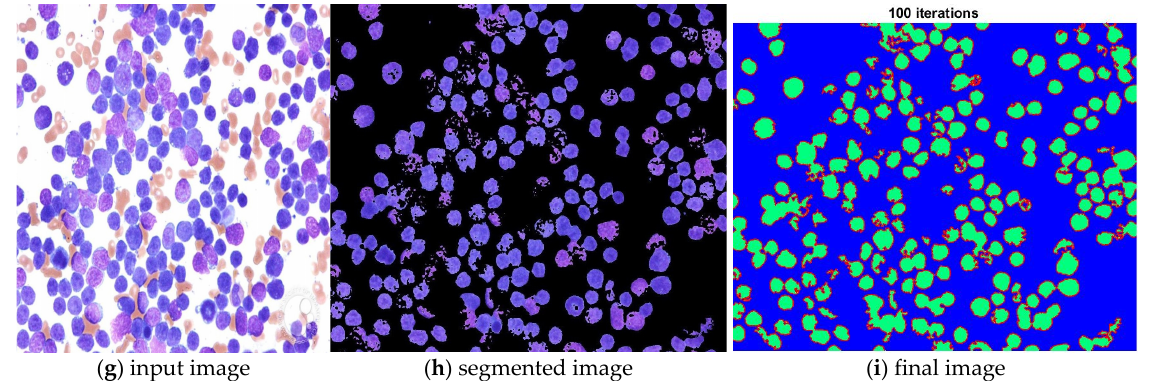
Figure 9. Demarcation with a red hue to each extracted nucleus.